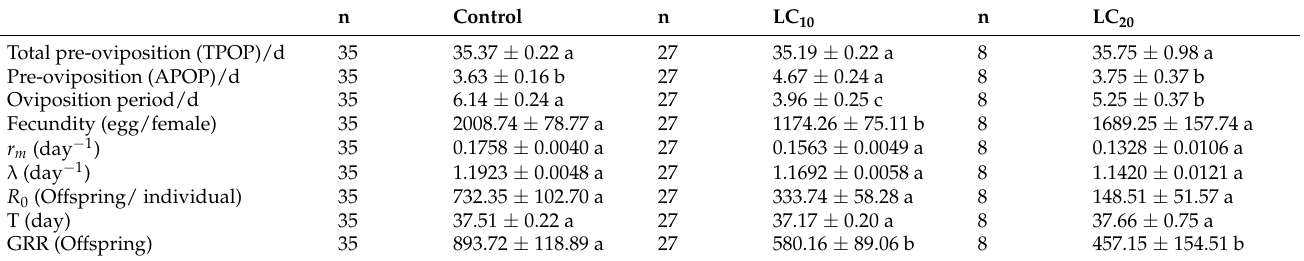
Table 6. Sublethal effects of EMB on the reproduction and population parameters of the FAW offspring